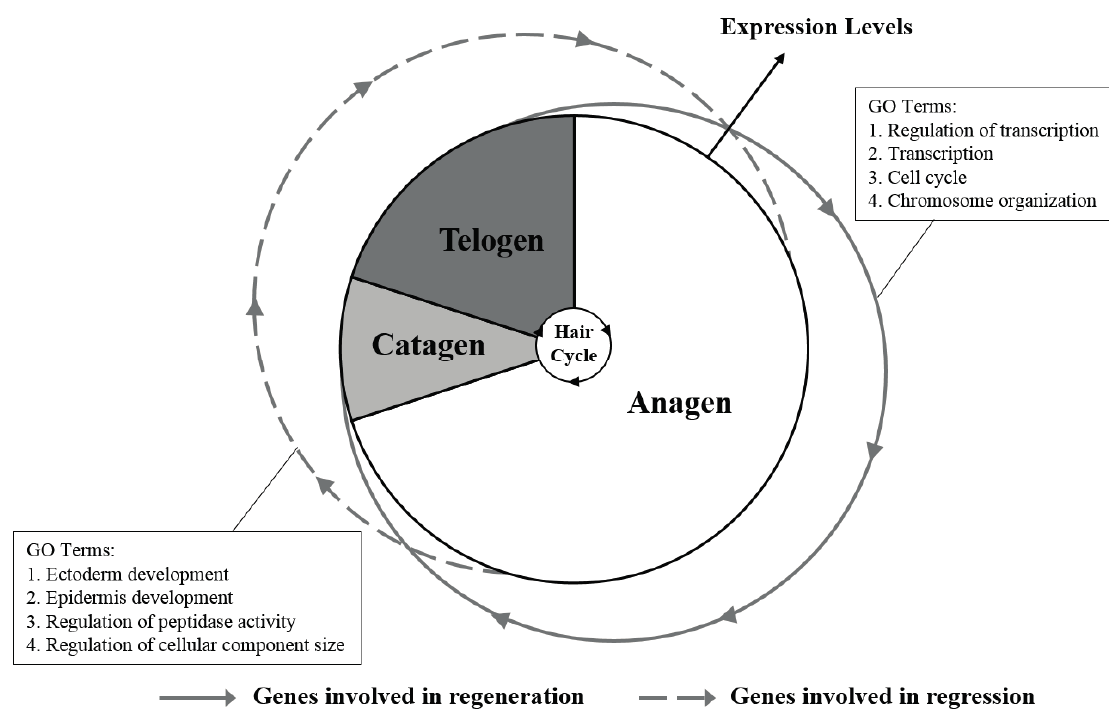
Figure 4. The gene expression patterns during the wool follicle bulb regression and regeneration. Two groups of genes that presented the distinct expression patterns during the phase-transformation may have important roles for the wool follicle bulb regression and regeneration. Of these two groups of genes, one group of them was upregulated in catagen, then downregulated in the middle anagen of the next cycle (regression-associated genes). The GO terms analysis revealed that these genes were related to epidermis development, cell morphology and apoptosis. Whereas the other group of genes were upregulated in the late telogen/early anagen phase, then downregulated in the catagen phase (regeneration-associated genes), these genes were related to cell proliferation and